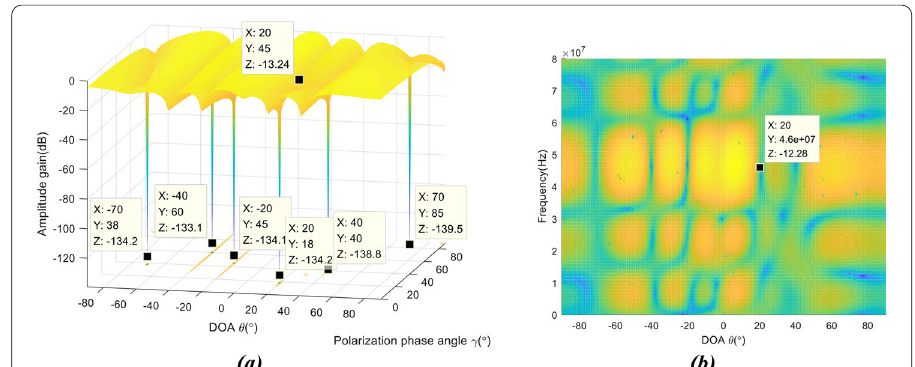
Fig. 5 Three-dimensional beam pattern for the APSA-STPAP algorithm a space-polarization domain null pattern and b top view of the space–time domain null pattern